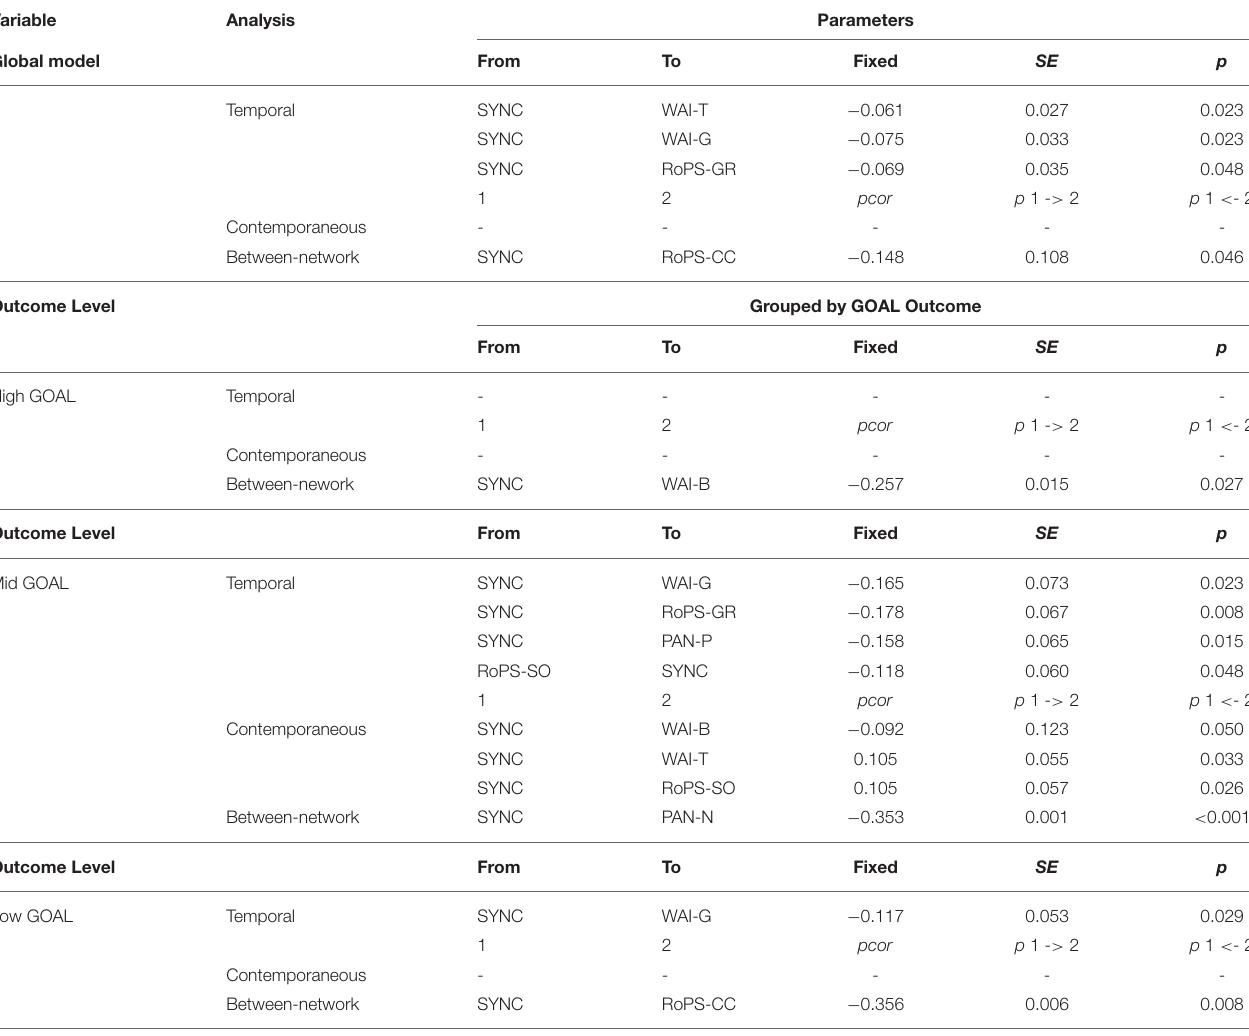
TABLE 3 | Parameter Estimates (and Standard Errors) for Network Models.